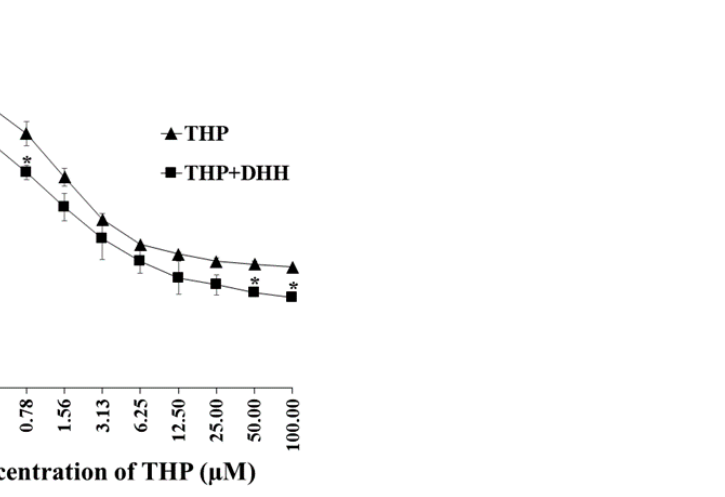
tured in 100 µL medium in the presence of 0.5% DMSO, with 55.6 µM DHH in the presence of cultured in 100 µ L medium in the presence of 0.5% DMSO, with 55.6 µ M DHH in the presence